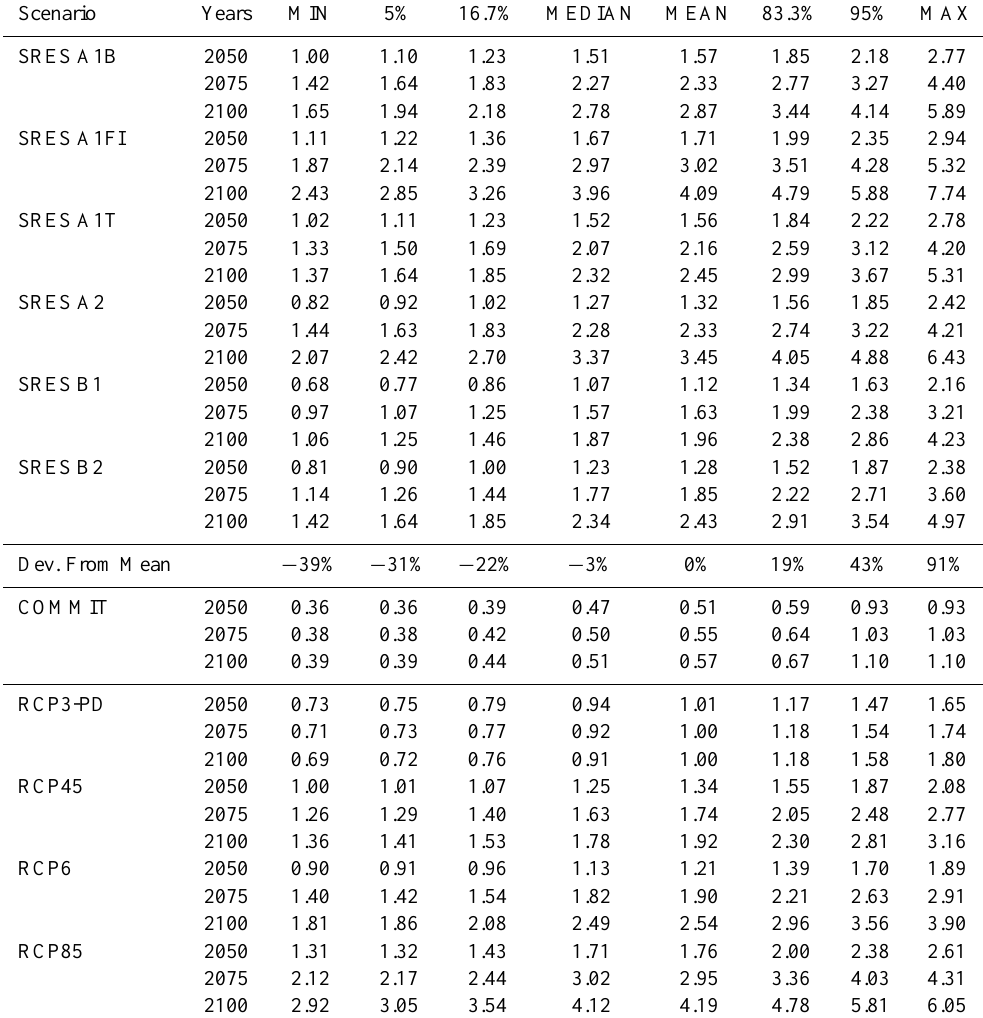
Table 1. Distributions of temperature projections for 2050, 2075 and 2100 for the six illustrative SRES scenarios, for the “Year 2000 concentration stabilization” (COMMIT) experiment and the four RCP scenarios – relative to the 1980–1999 mean. To convert warming relative to 1980–1999 as provided here into warming relative to a proxy for pre-industrial levels (i.e., the average over the first 70 years of the observational record, 1850–1919), 0.5 ◦ C should be added (see HadCRUt3v as described in Brohan et al., 2006). The distribution percentiles in the header row denote the cumulative density of occurrence of the cross-combination between calibrations to CMIP3 AOGCMs and C 4 MIP carbon cycle models. The row denoted “Dev. From Mean” provides the average deviations from the mean across all six SRES scenarios and the three time